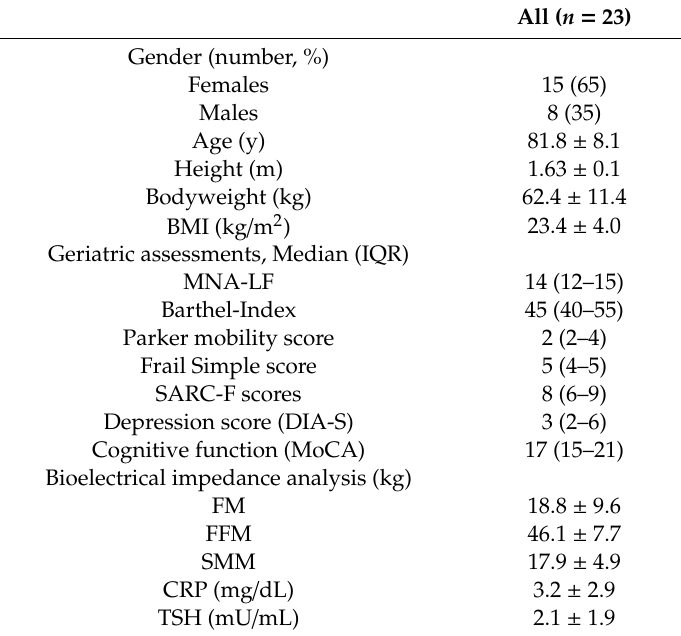
Table 1. Characteristic of the study population on admission.